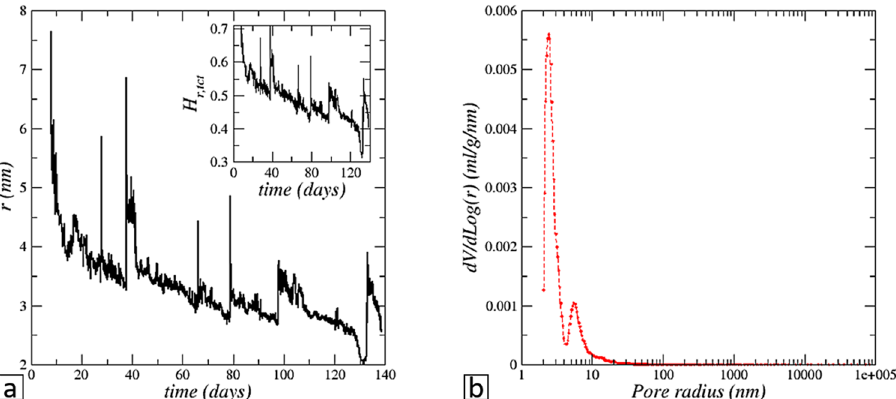
Figure 7. ( a ) Variation of menisci curvature radius at the crust top surface compatible with the evaporation rates observed in the experiment according to Kelvin relationship. The inset shows the computed relative humidity at the travelling crust top surface. ( b ) Salt crust pore size distribution from mercury intrusion porosimetry (see